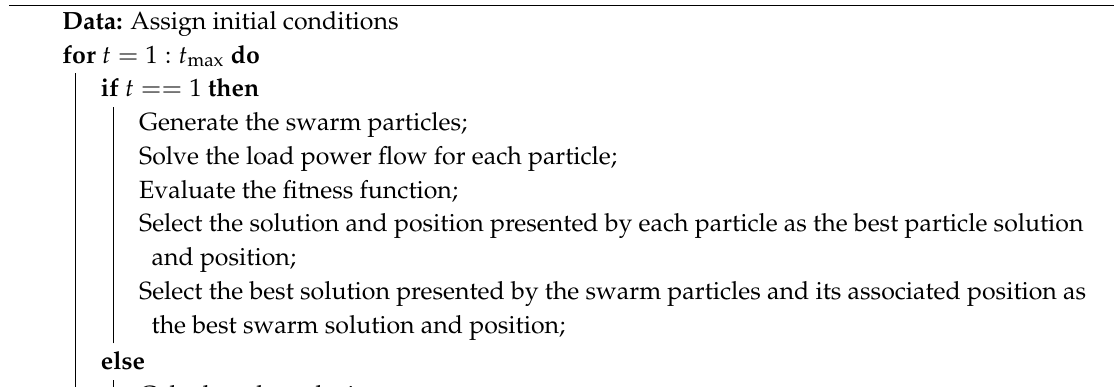
Algorithm 2: Pseudo-code for the PSO